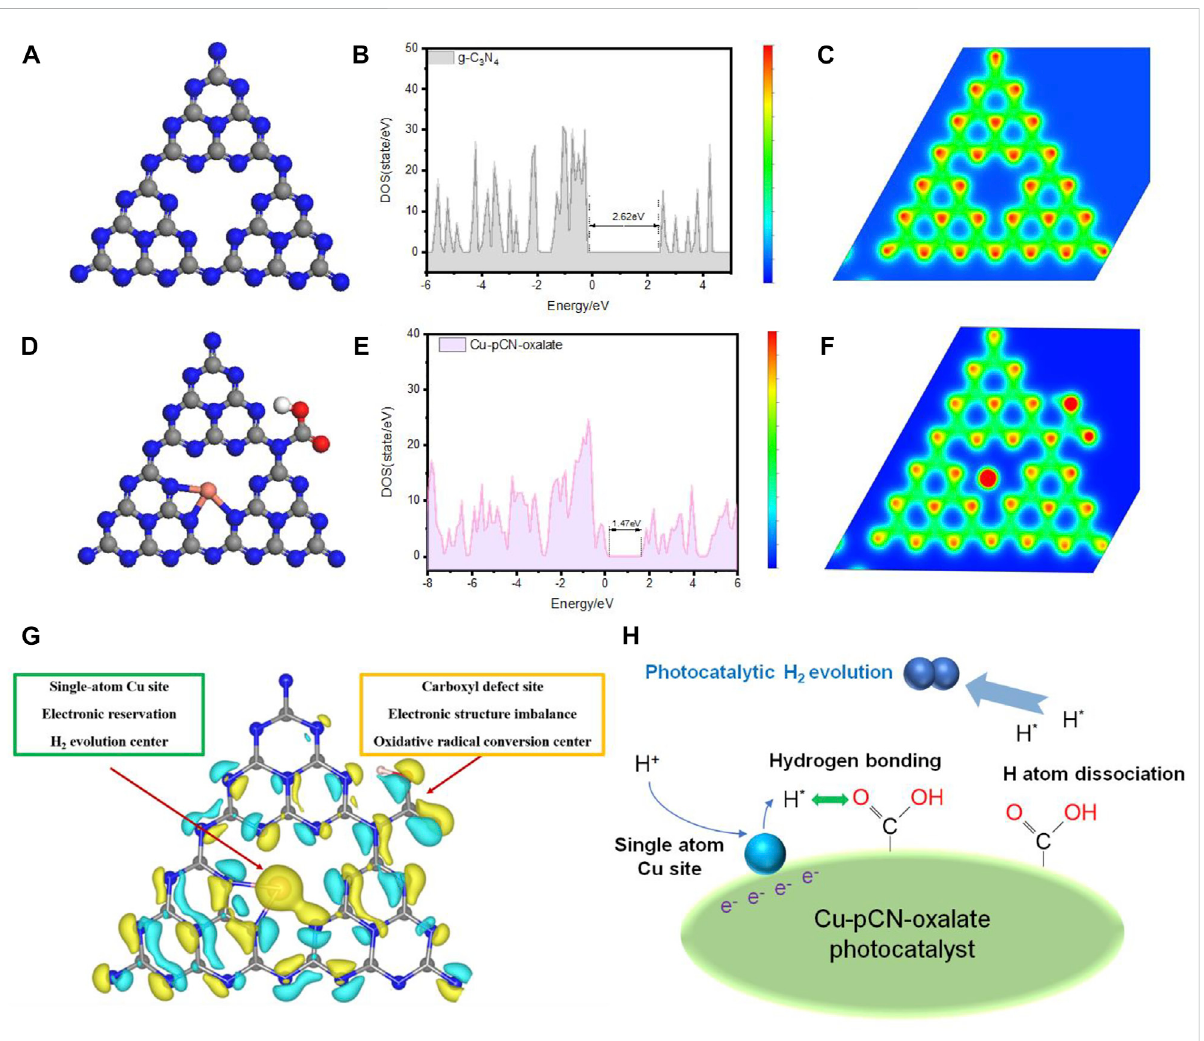
FIGURE 9 Structurediagramsandcorrespondingtotaldensityofstatesof (A , B) rawg-C 3 N 4 and (D , E) Cu-pCN-oxalateandtheschematicdiagramoflocal charge analysis of (C) raw g-C 3 N 4 and (F) Cu-pCN-oxalate (gray, blue, pink, and red spheres: C, N, Cu, and O, respectively). (G) Proposed synergistic mechanism of single-atom Cu sites and the carboxyl defect sites of the Cu-pCN-oxalate photocatalysts in a typical 3D map of differential charge densities of Cu-pCN-oxalate. (H) Proposed reaction mechanism involving the single-atom Cu sites and the carboxyl defect